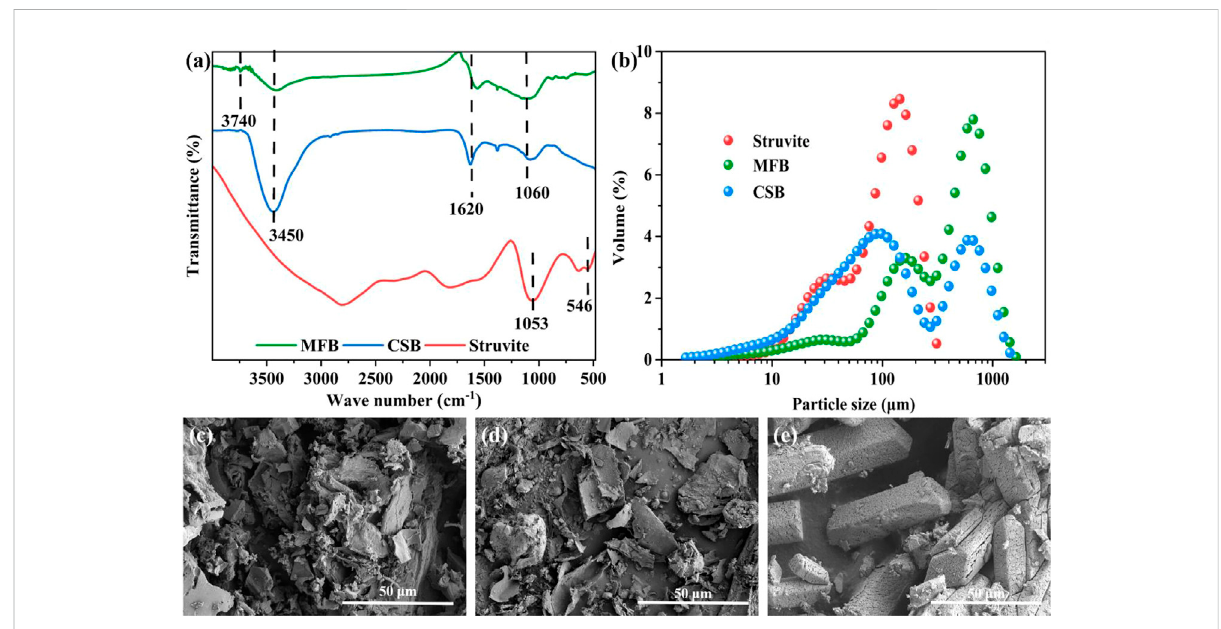
FIGURE 2 (A) FT-IR spectra of MFB, CSB, and struvite; (B) particle size distribution of MFB, CSB, and struvite; (C) SEM images of MFB; (D) SEM images of CSB; and (E) SEM images of